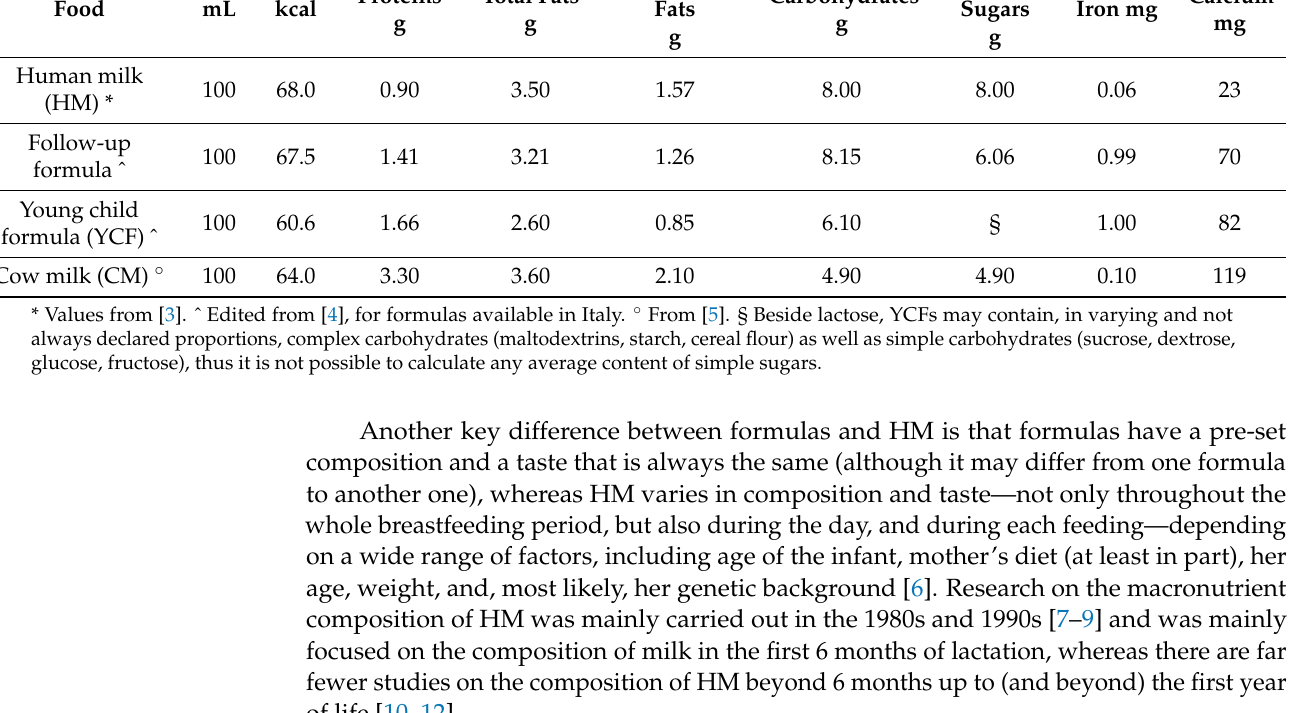
Table 1. Composition of human breast milk, follow-up formulas, young child formulas (YCFs), and cow milk (CM).